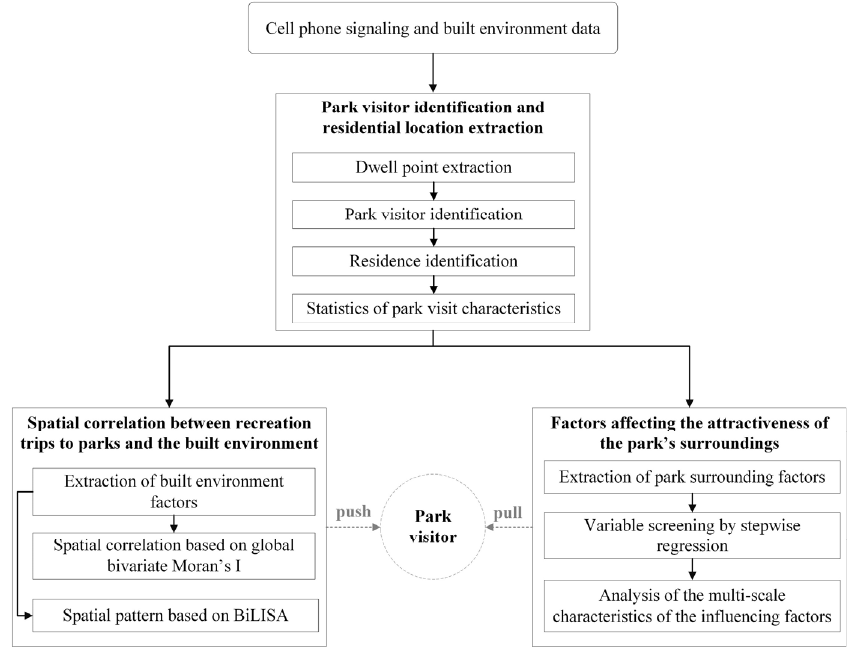
Figure 2. The research methodology and flow chart of data analysis. First, we extracted the dwell points in the cell phone signaling data. A location where a resident exceeds the dwell time threshold (30 min) at a base station or multiple adjacent base stations during a trip was taken as a dwell point, and the latitude and longitude location of the dwell point was derived by the algorithm provided by China Mobile Communications Group Shenzhen Co., Ltd. Second, park visitors were extracted from the information provided by the dwell point data. The records that were not present in Shenzhen at night in one month were excluded to obtain the records of Shenzhen residents. Furthermore, records of park staff and short stays were removed to obtain results for all park visitors. Finally, we extracted the residences of park visitors and aggregated the visit characteristics of each park and the travel characteristics of each grid cell. In cities, parks are not always equitably distributed. Access to parkland is often based on age and gender, as well as other axes of difference. However, the criteria for classifying sociodemographic characteristics are not uniform for different research purposes. For example, Veitch [45] chose women aged 18–45 and children aged 5–12 to study differences in park characteristics between urban and rural areas, and Sister [17] used the number of children (aged under 17) as an index of park demand. Teenagers under the age of 18 have more opportunities to visit parks after school and on holidays, and older adults have more time to participate in park recreation after retirement in China. Therefore, we divided the park visitors into three groups in terms of availability of park recreation participation time (as shown in Table 1). the retirement age between males and females, so here we used 55 years old for women and 60 years old for men as the retirement age threshold, and we also used this to